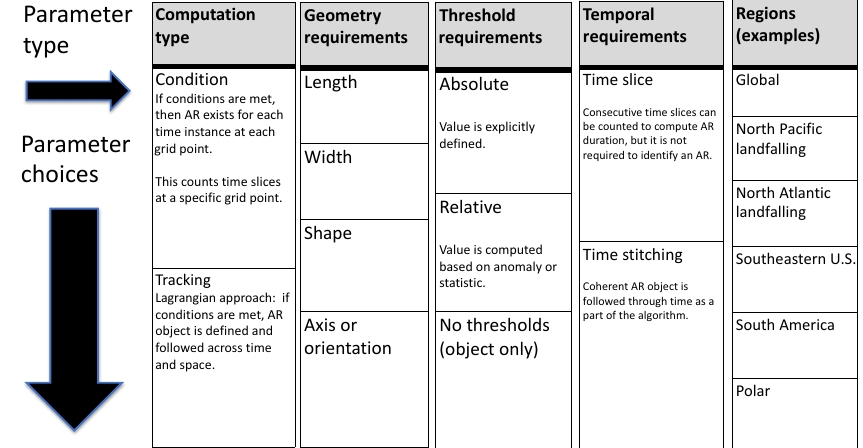
Figure 1. Schematic diagram illustrating the diversity on AR detection algorithms found in current literature by categorizing the variety of parameters used for identification and tracking, and then listing different types of choices available per